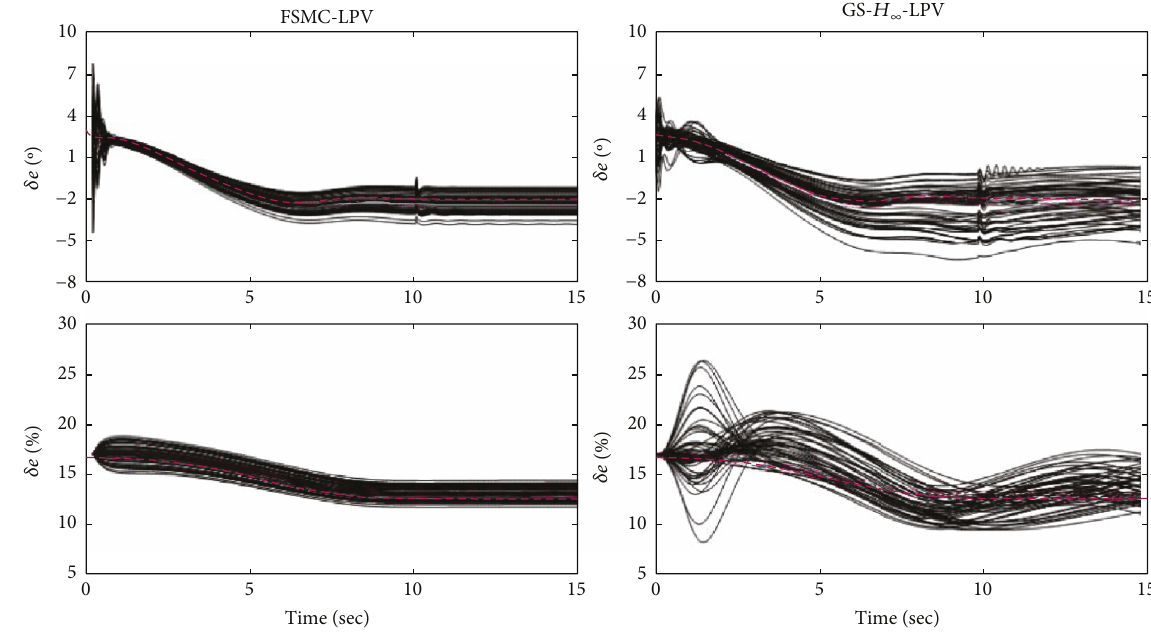
Figure 12: Closed-loop controller outputs. Table 2: Partial velocity of each